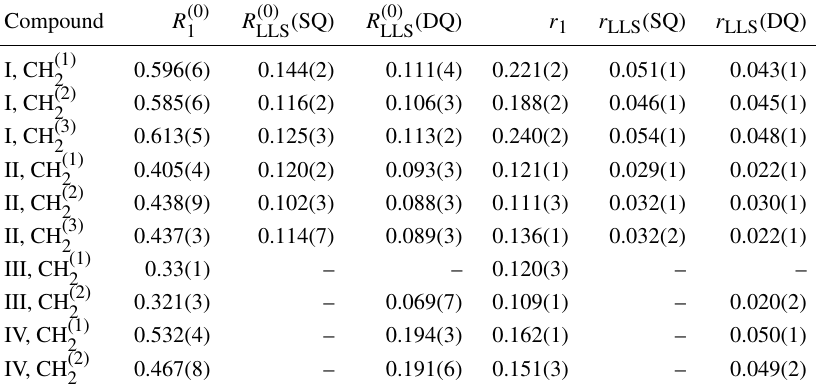
Table 1. Experimentally determined relaxation rate constants (s − 1 ) and relaxivities (M − 1 s − 1 ). Standard errors determined from linear regressions are shown in parentheses. For double SLIC, the RF amplitude was chosen to match the condition for double-quantum level anti- crossing (LAC), leading to different imbalances characterized by different rate constants R (0) (SQ) with single SLIC excitation and single LLS SLIC reconversion, and to rate constants R (0) (DQ) with triple SLIC excitation and single SLIC reconversion. LLS R (0) Compound R (0) 1 LLS